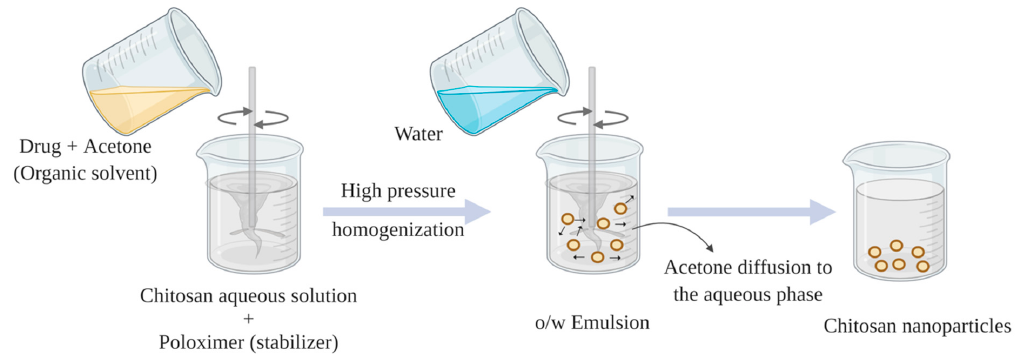
Figure 7. Schematic diagram of chitosan nanoparticles prepared via emulsion solvent diffusion.